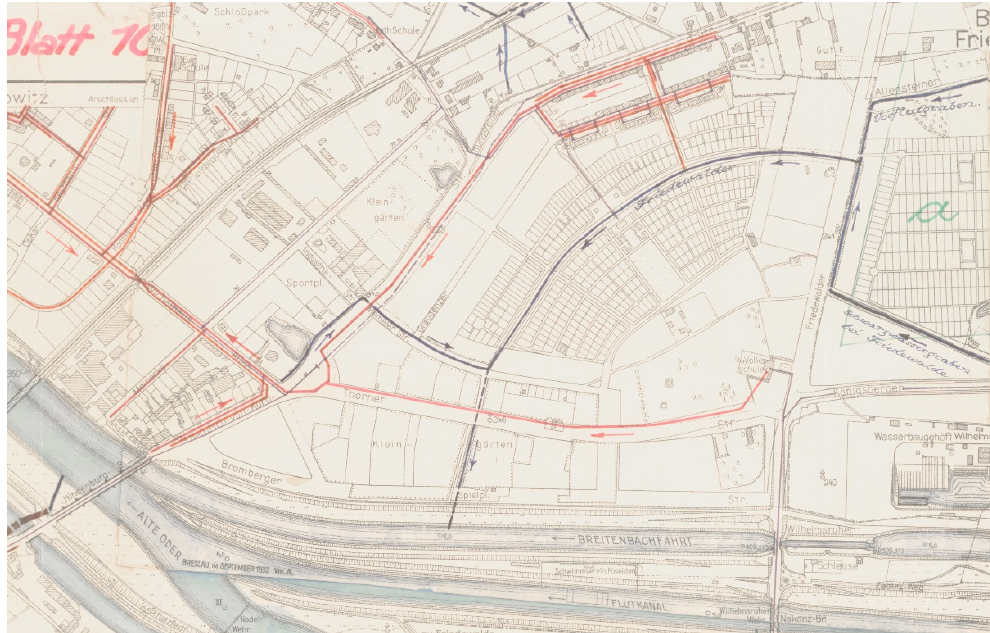
Figure 3. Fragment of section plan of Wrocław (at that time Ger. Breslau) from the 1930, with an establishment comprising an allotment garden colony—at present “ROD Wytchnienie” (Reproduction of archival documents from the collections of the Building Archive in Wrocław, sign. 110479).